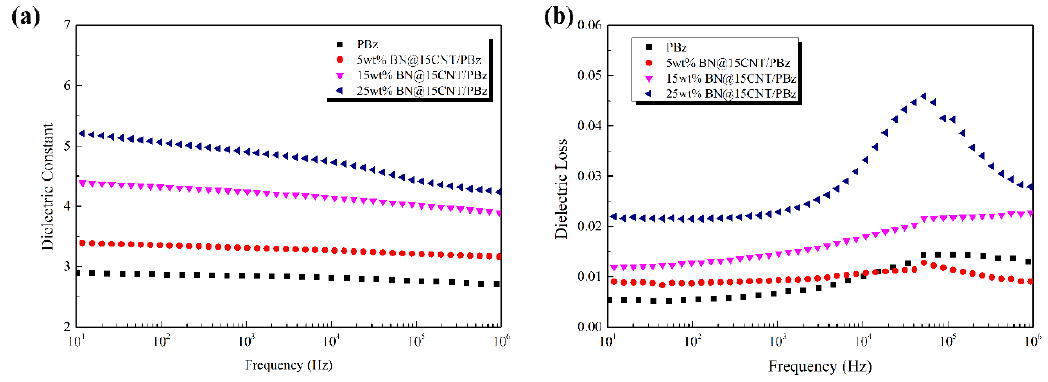
Figure 10. ( a ) ε and ( b ) tan δ values of PBz composites with di ff erent content of BN@15CNT at di ff erent Figure. 10 ( a ) ε and ( b ) tan δ values of PBz composites with different content of BN@15CNT at different testing testing frequency